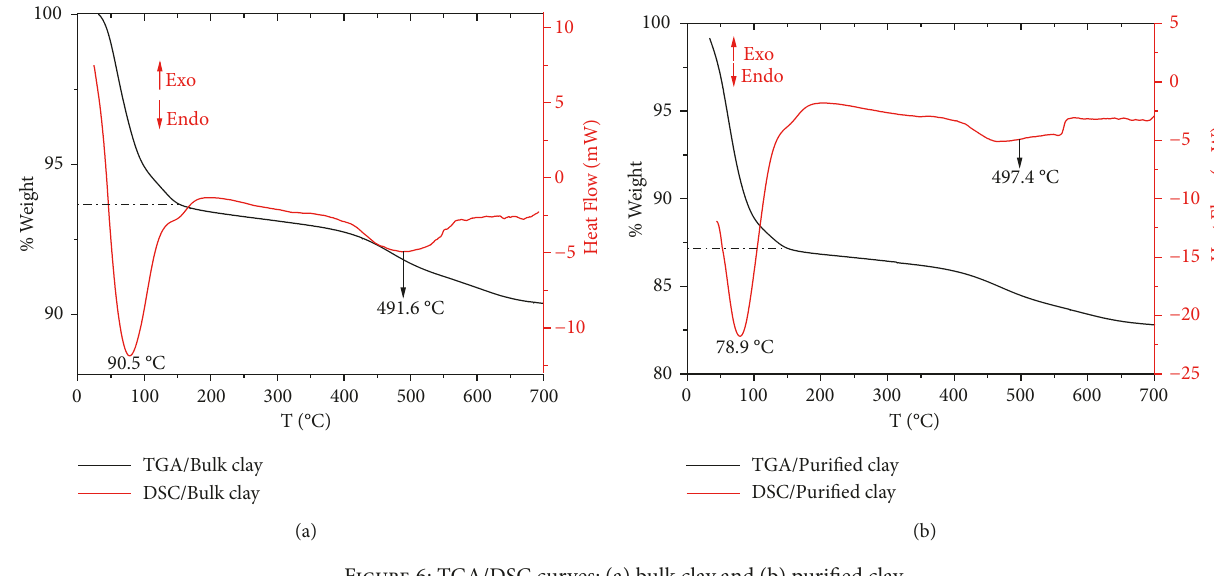
Figure 6: TGA/DSC curves: (a) bulk clay and (b) purified clay.